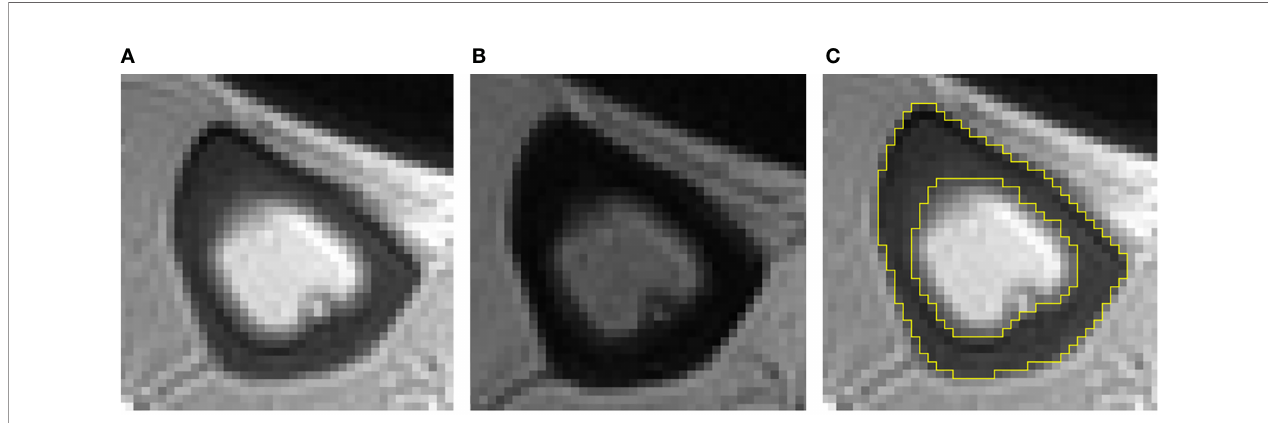
FIGURE 1 | Typical double-echo UTE images and ROI of the tibia (A – C) . (A) The image of fi rst echo; (B) the image of second echo; (C) example of